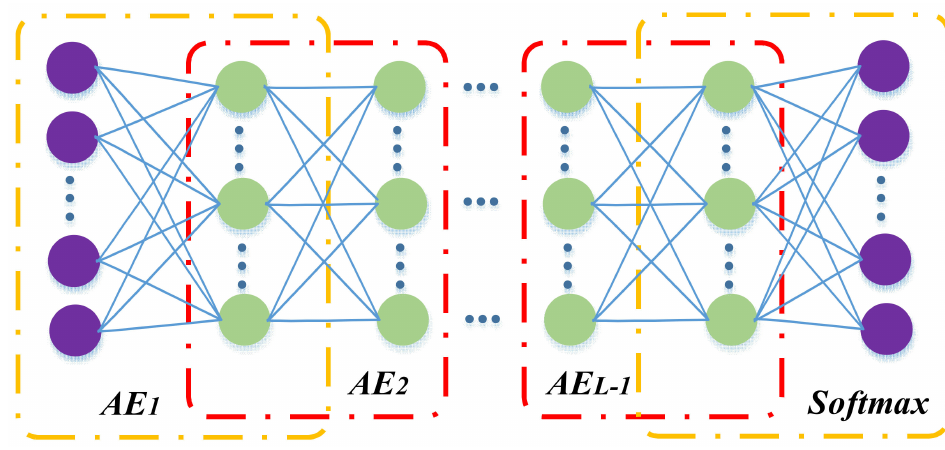
Figure 1. The framework of deep auto-encoder